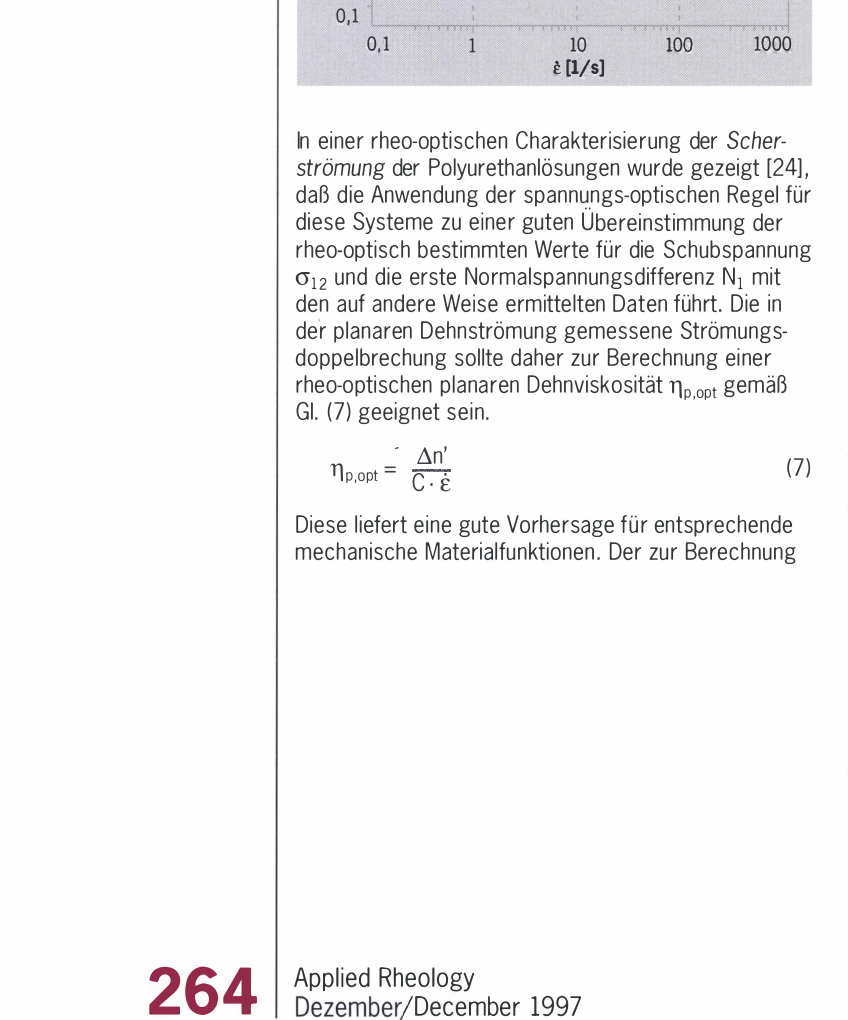
Fig. 5: Rhea-optically determined planar extensional viscosities for three polymer solutions with different